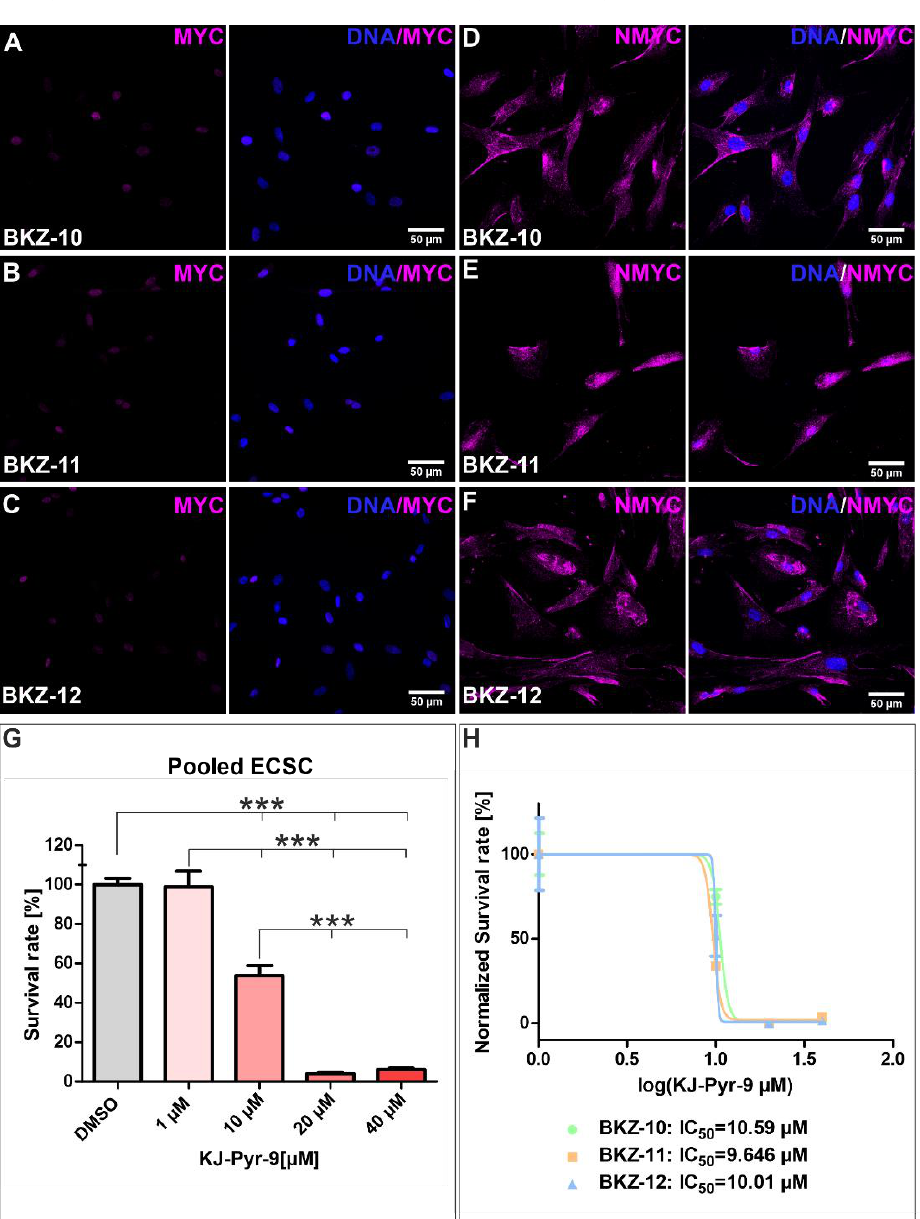
Figure 6. Inhibition of the MYC and NMYC protein interaction with MYC-associated factor X (MAX) decreases the survival of endometrial carcinoma-derived stem-like cell populations. Immunocytochemical staining revealed ( A – C ) predominantly nuclear MYC protein as well as ( D – F ) cytosolic NMYC protein for all three ECSC populations, respectively. To analyze the influence of the MYC/NMYC inhibitor KJ-Pyr-9, cells were treated with different concentrations for 120 h. Subsequent, viability was measured using Orangu TM (Cell Guidance Systems, Cambridge, U.K., Cambridge, U.K.) and the cell count was determined by using a standard curve. ( G ) Statistical analysis revealed a significantly impaired survival of ECSCs upon application of 20, 40 and 60 µM KJ-Pyr-9. ( H ) Analysis of the half maximal inhibitory concentration (IC 50 ) revealed an IC 50 value of 10.59 µM KJ-Pyr-9 for BKZ-10, 9.646 µ M KJ-Pyr-9 for BKZ-11 and 10.01 µ M KJ-Pyr-9 for BKZ-12. Means ± SEM (standard error of the mean) were statistically analyzed by a non-parametric Mann–Whitney test ( n = 3, *** p ≤